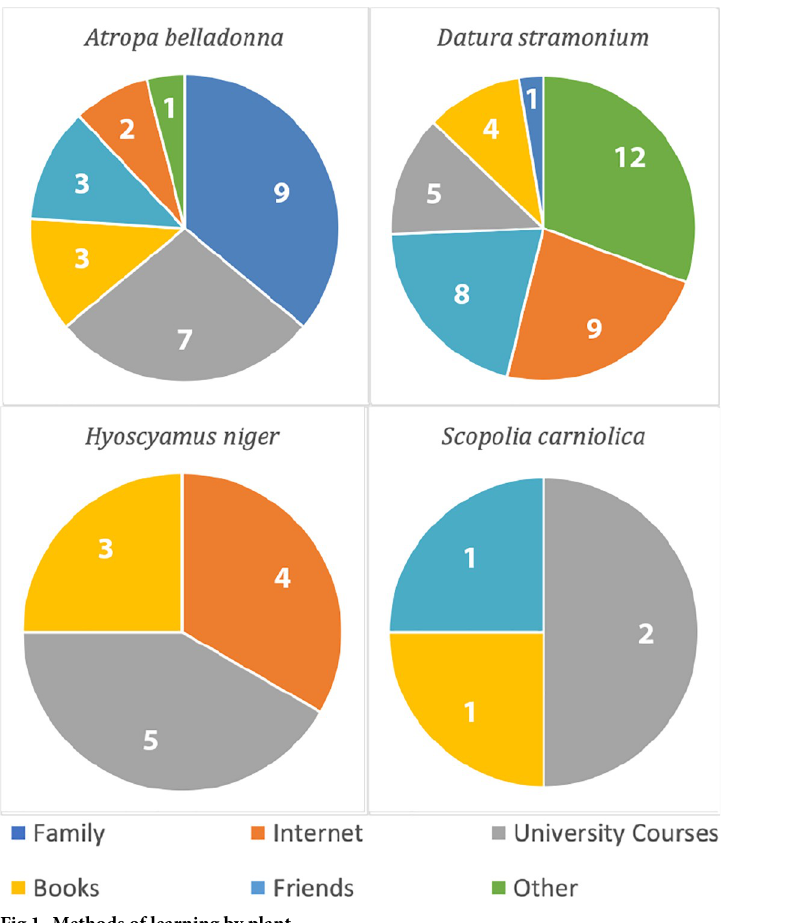
Fig 1. Methods of learning by